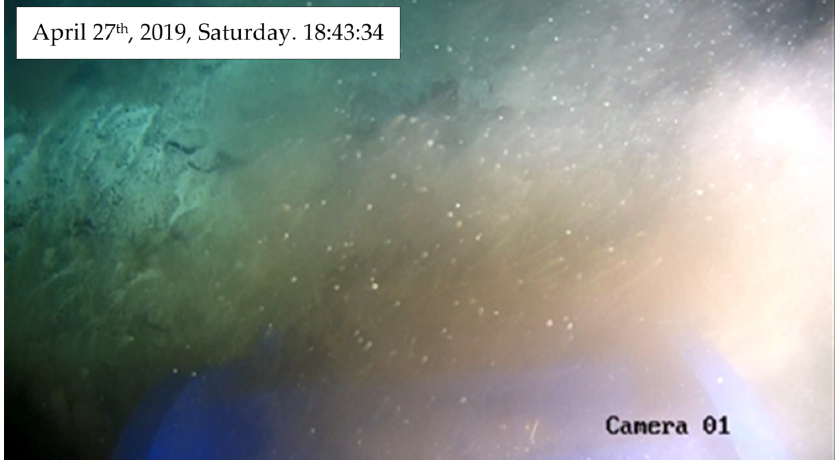
Figure 18. Camera image during cutting.